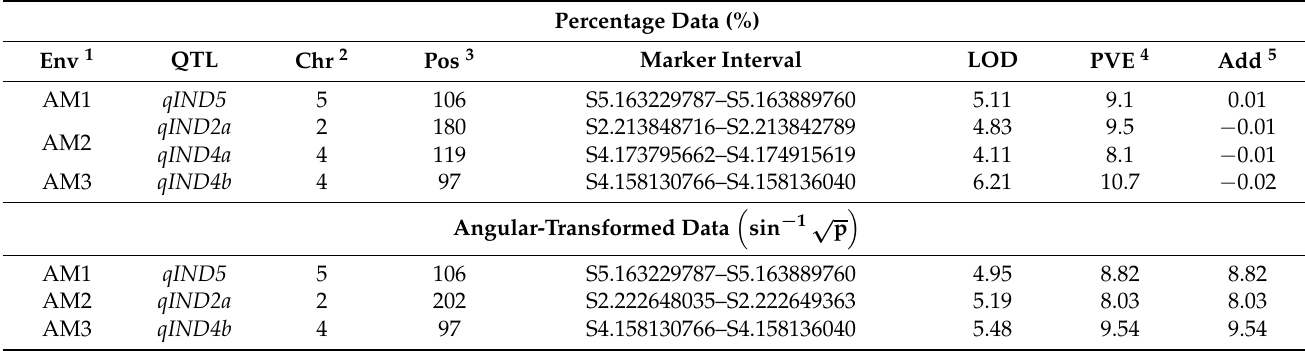
Table 3. QTL identified in three locations for inducibility using percentage and angular-transformed data. Percentage Data